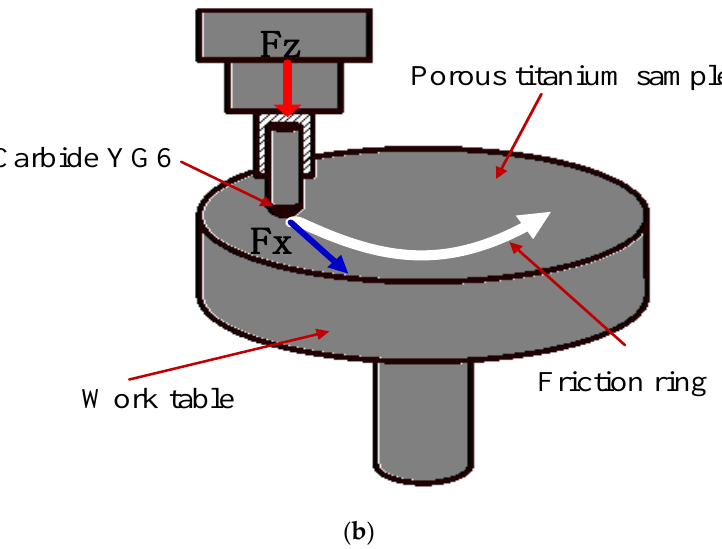
Figure 4. The diagram of the experimental equipment: ( a ) the testing instrument; and ( b ) the principle of friction and wear. Table 3. Detailed parameters of the grinding ball.